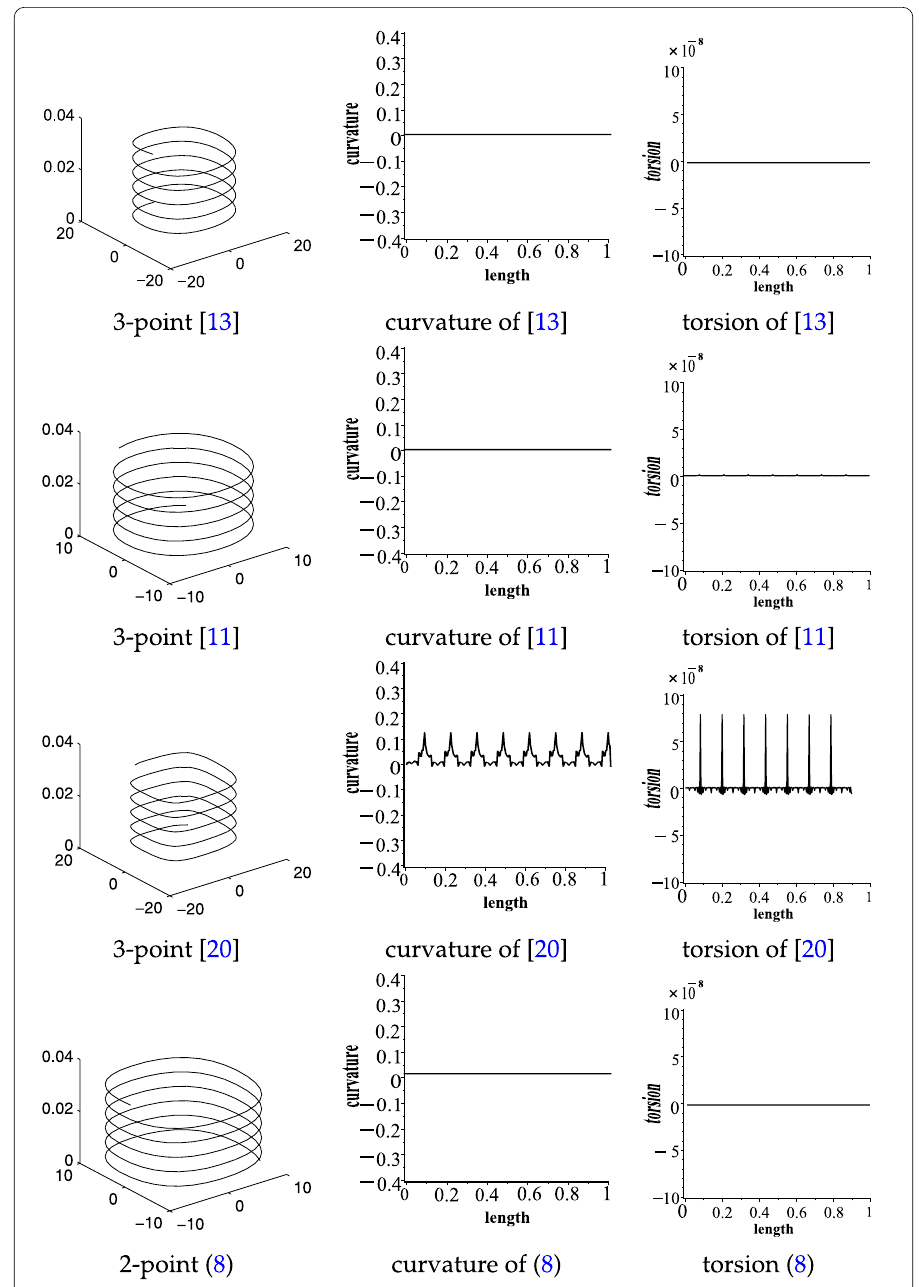
Figure 1 Limit curves obtained after the fifth iteration (left), the corresponding curvature (center) and torsion (right)